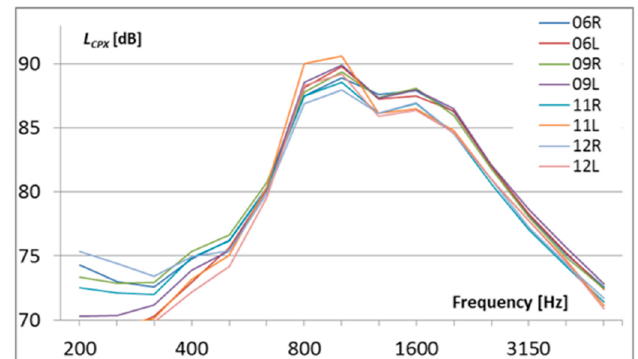
Figure 10. Frequency spectra measured at each individual tire on the ISO test track (the numbers in the legend indicate year) (source from Oddershede and Kragh, 2014 [108], Figure 6; reprinted with permission from Mr. Jens Oddershede of Vejdirektoratet, Denmark).